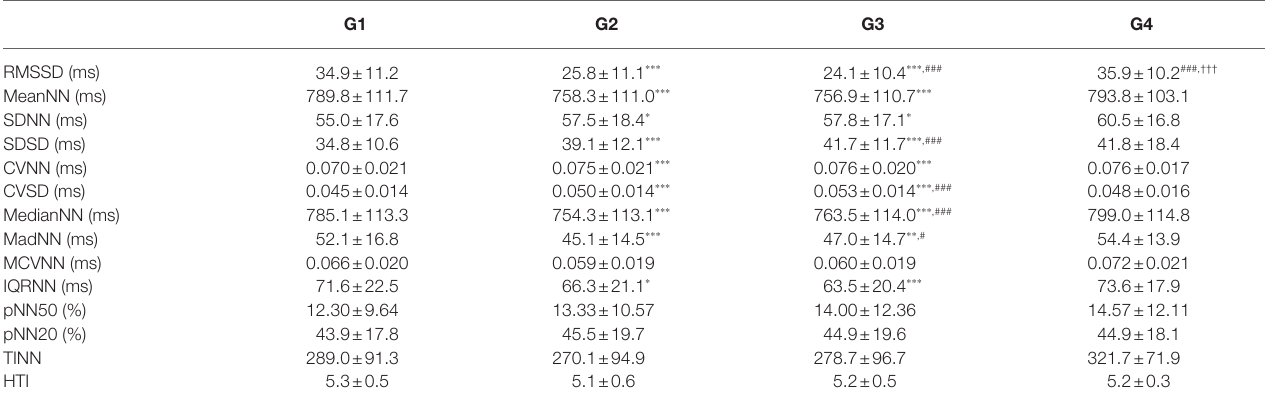
TABLE 3 | HRV time-domain features (absolute values are means ± SD).